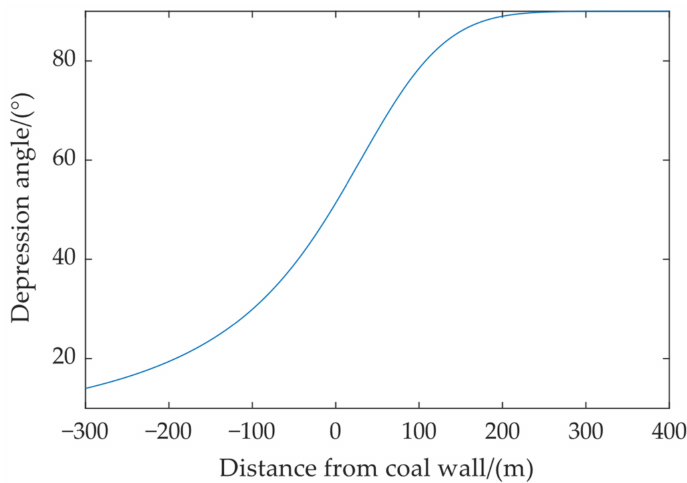
Figure 4. Change in depression angles of surface points on main